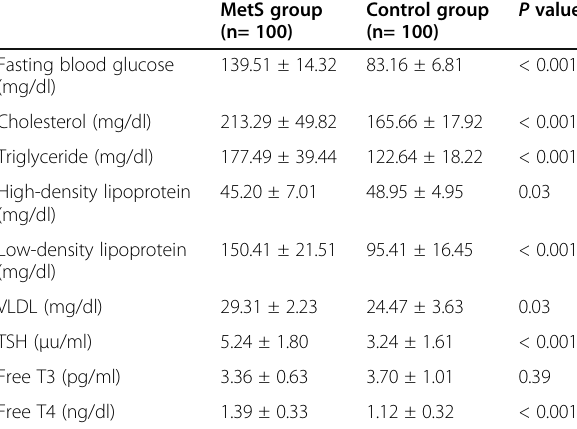
Table 3 Baseline laboratory data among the studied